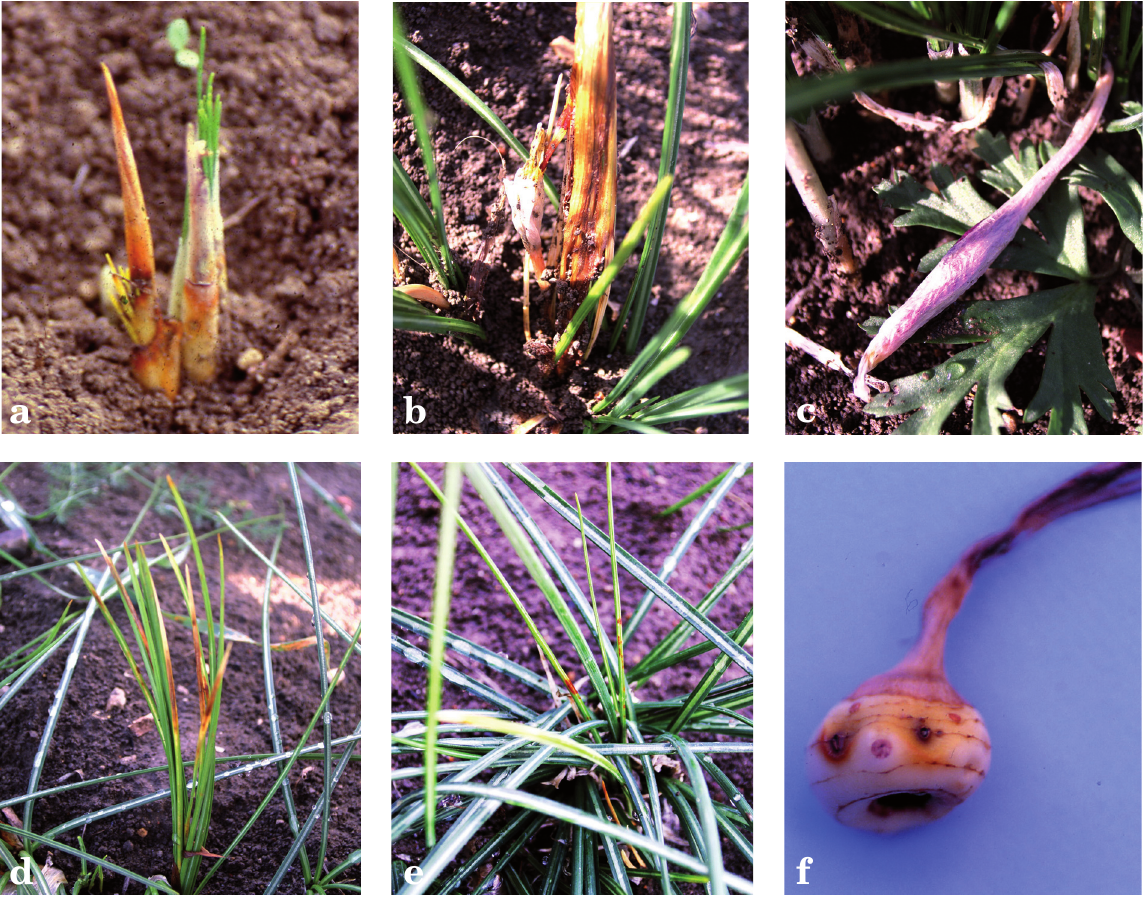
Figure 1. Symptoms of bacterial softrot in naturally infected saffron plants and corms: rot on emerging shoots, leaves and flowers (a, b and c); spots on leaves (d and e); brown marks surrounded by reddish brown halos on corm